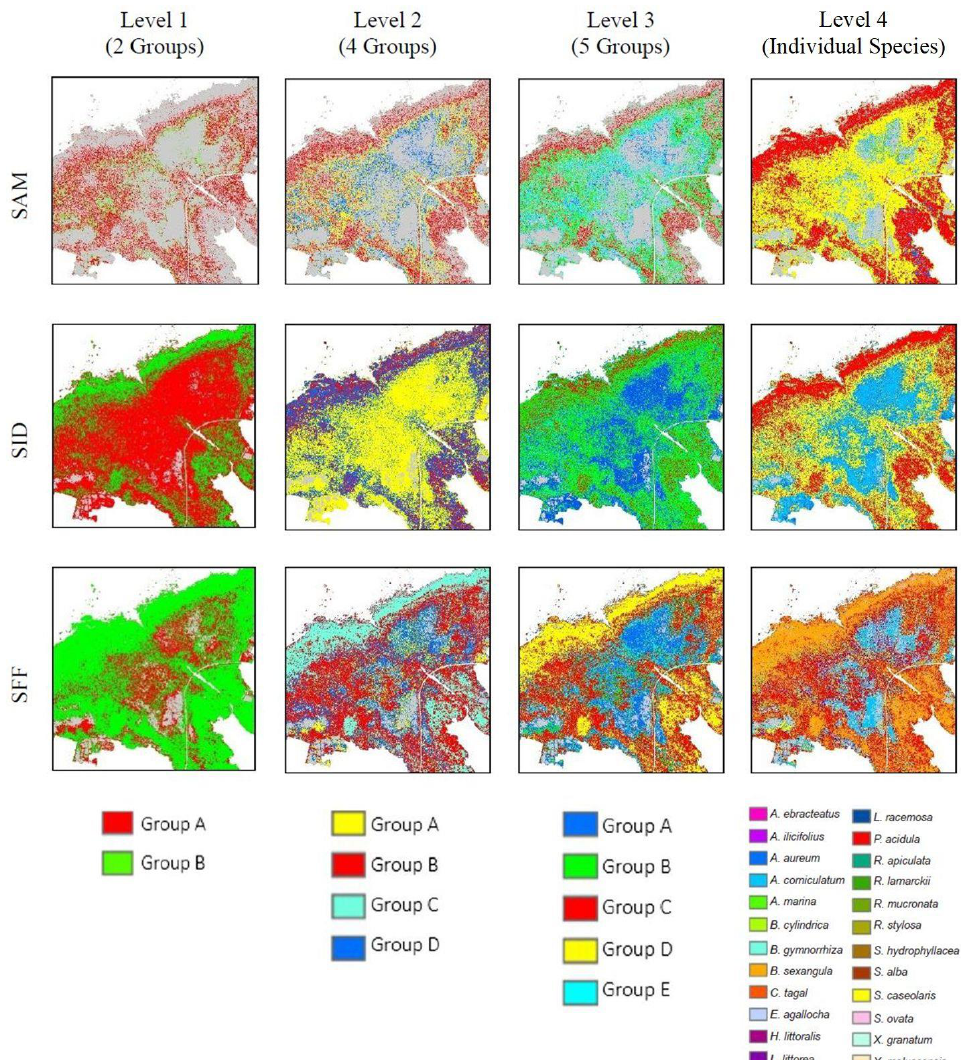
Figure 6. Mangrove species mapping results using the SAM, SID, and SFF algorithms at group Levels 1 – 4. Levels